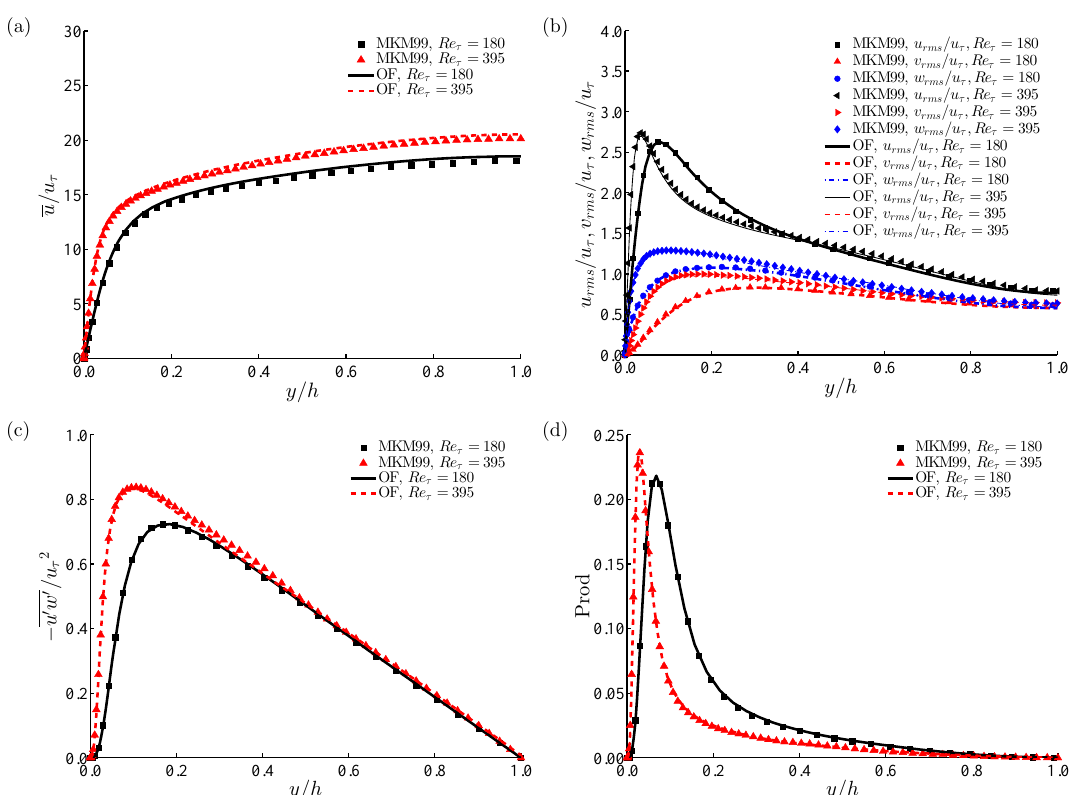
Figure A2. Comparisons of variables for neutral flows, Ri τ = 0. The lines are the results from the current solver (OF), and the symbols are results from Moser et al. (1999) (MKM99). The production of TKE are normalized by ν/u 4 τ . (a) Mean velocity, (b) rms velocity, (c) turbulent momentum flux, and (d) production of turbulence kinetic